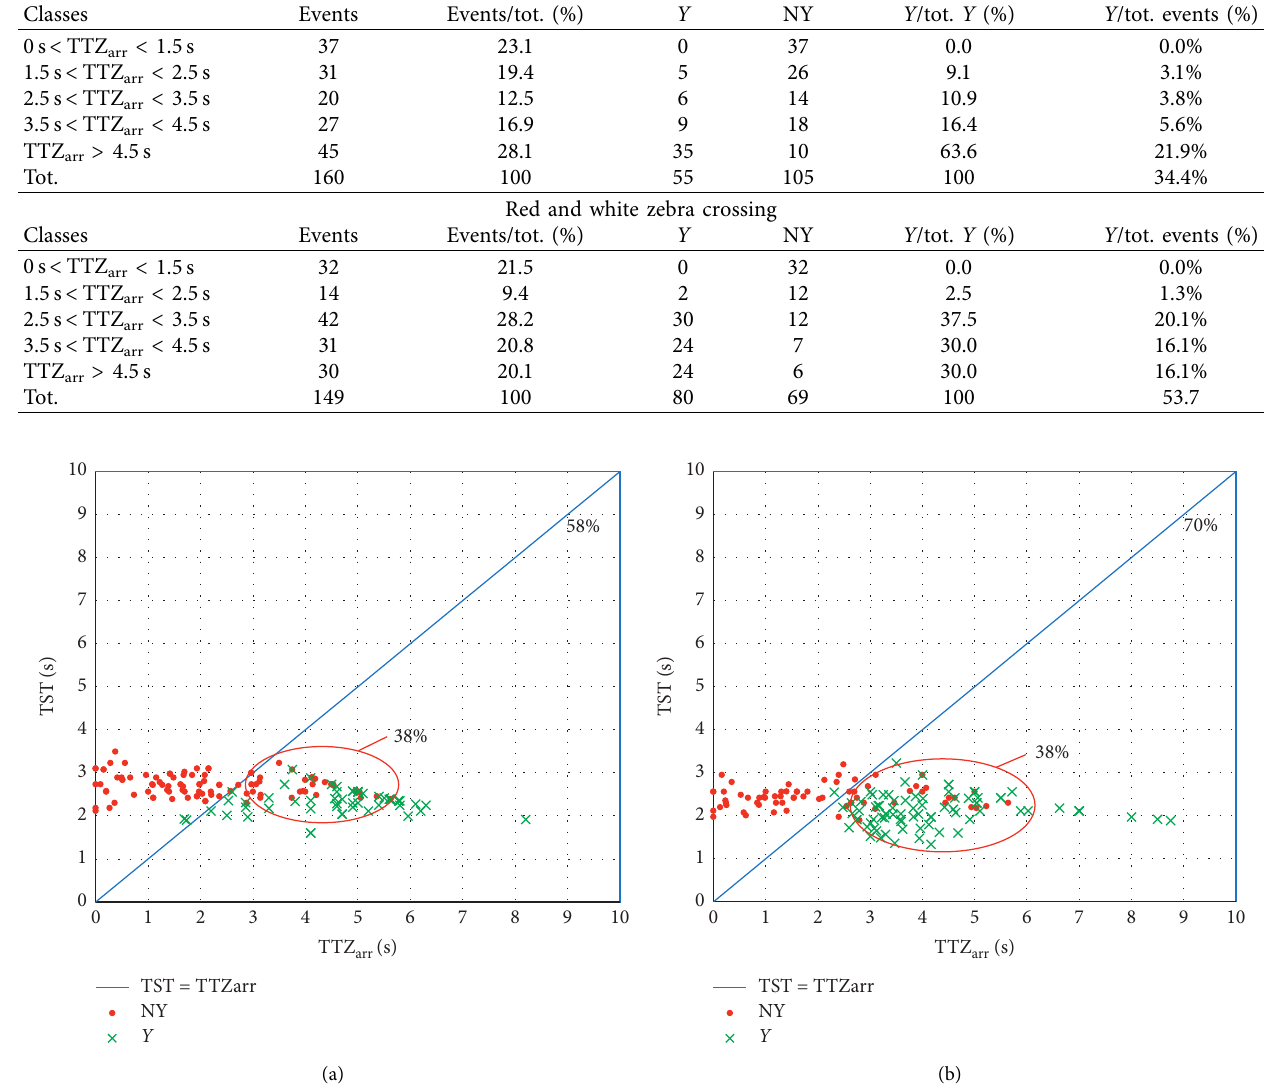
Figure 5: Total Stopping Time (TST): time to arrive (TT arr ) relationship for (a) white zebra crossing and (b) red and white zebra crossing.